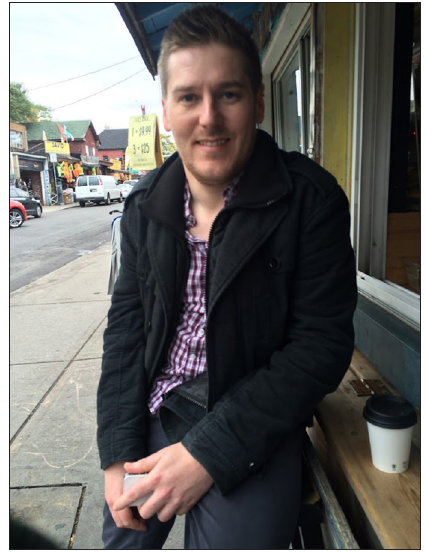
Figure 7: Nicky Garland, IoA PhD alum and former ASE staff member (Photo: Nicky